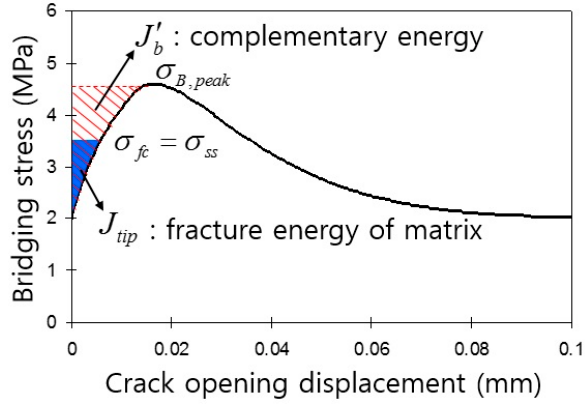
Figure 5. Typical fiber bridging curve for a strain hardening composite (adapted from [26]).